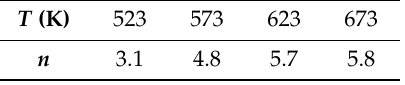
Table 5. Activation energy (kJ/mol) for nano-SiCp/AZ91 composite after hot deformation.